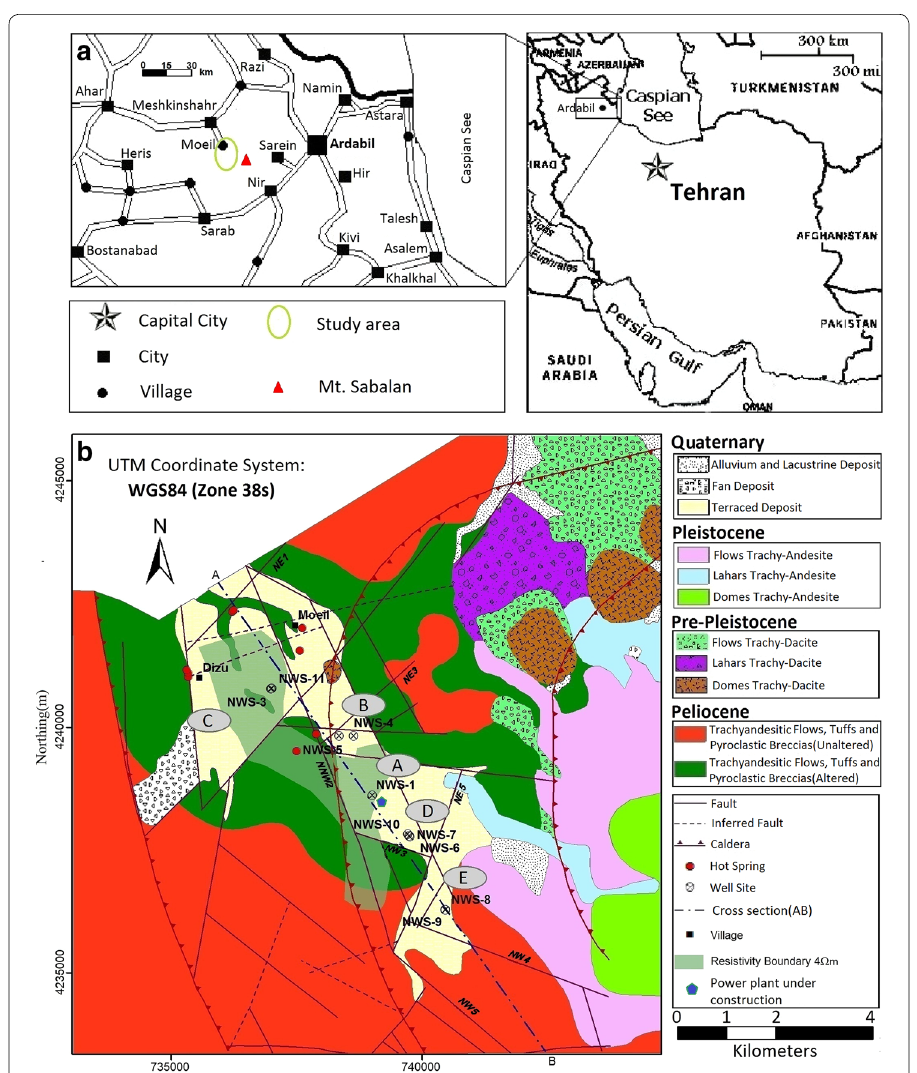
Fig. 1 a Geographical situation of study area, b geological map of west and northwest of Mt. Sabalan (based on KML 1999a, detailed faults map is based on EDC 2010)—geothermal wells and faults are shown in bold and bold italic , respectively. The letters A , B , C , D and E on geological map represent exploration well